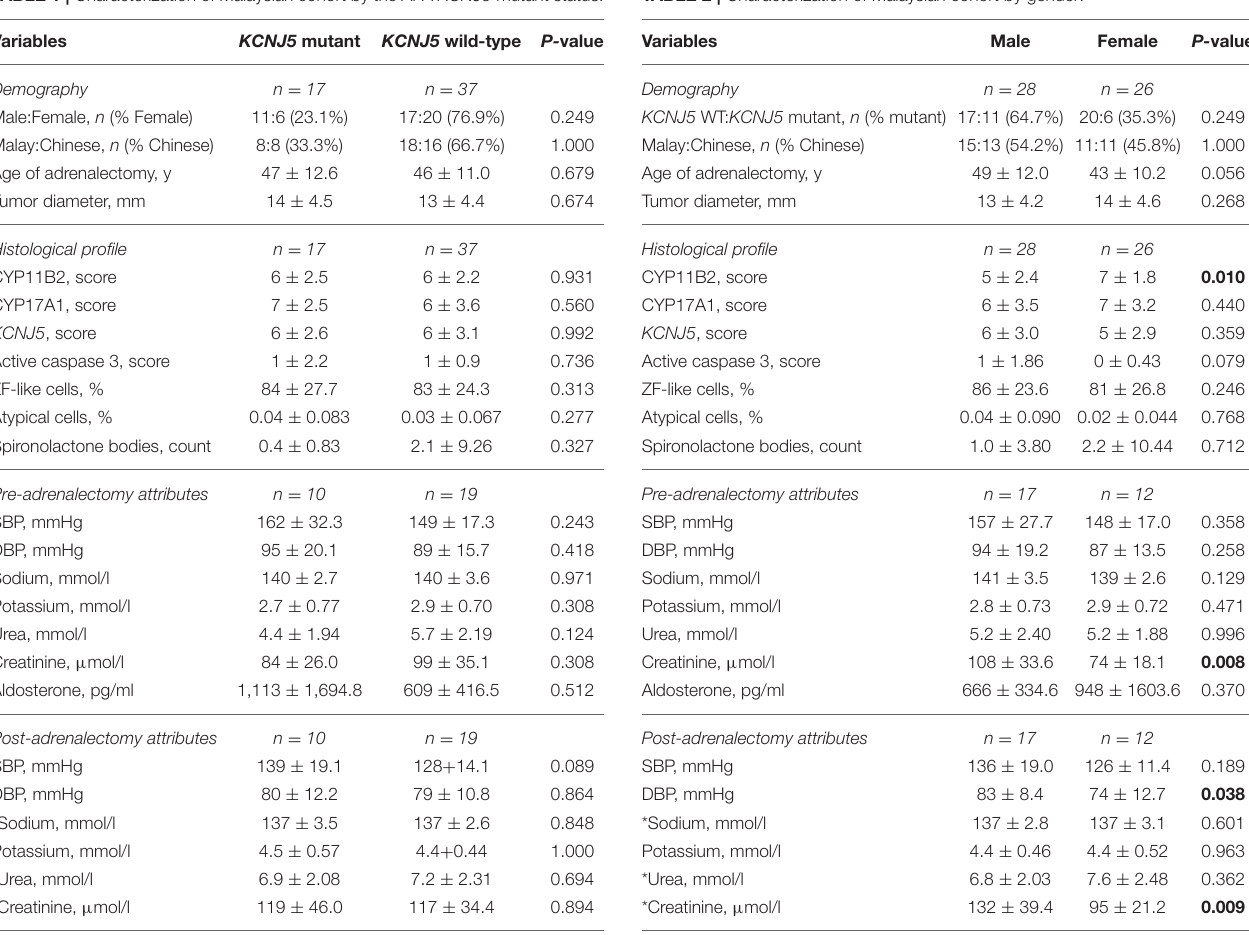
TABLE 2 | Characterization of Malaysian cohort by